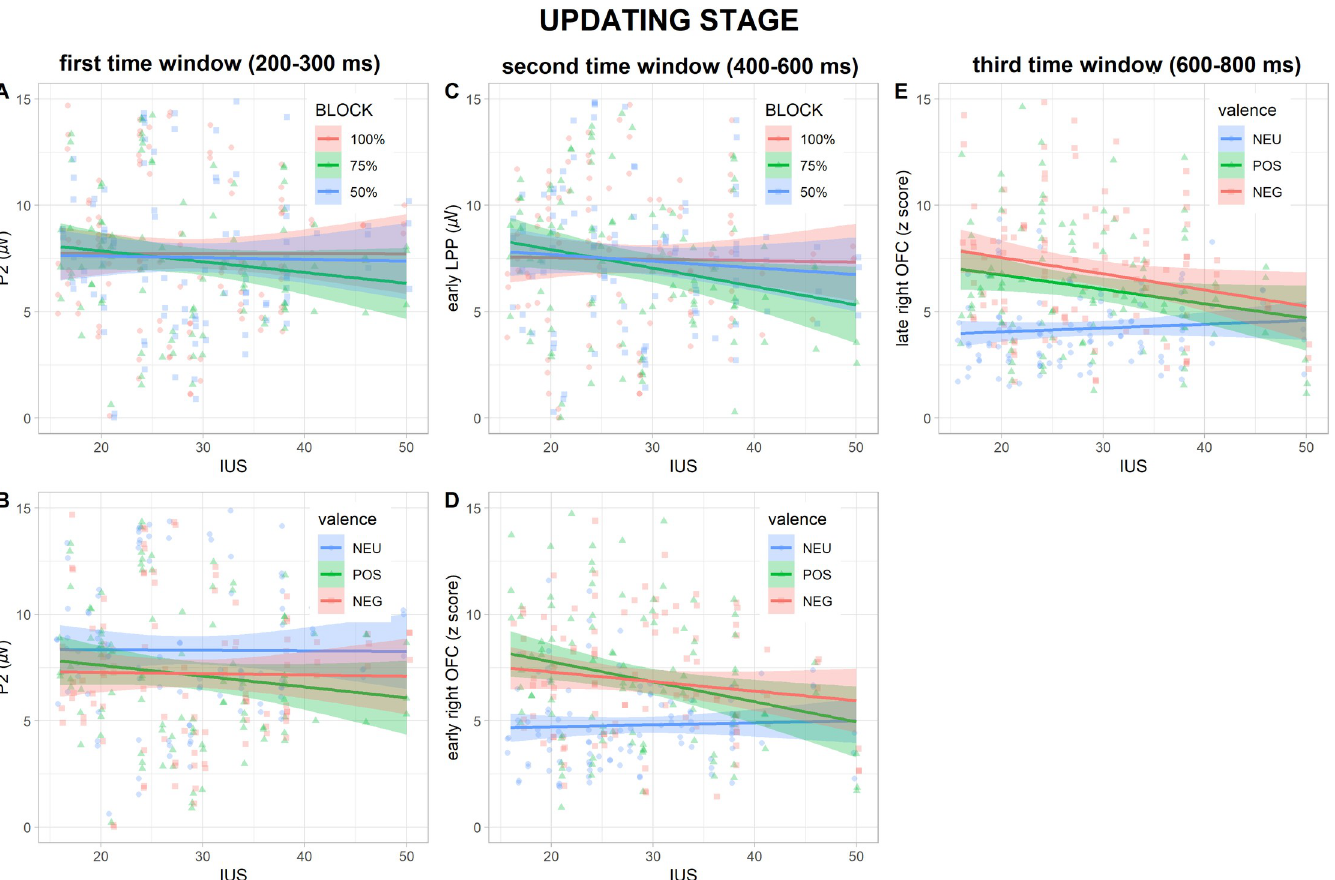
Fig 4. Regression plots in the three time windows of the prediction updating stage. Relationships between IUS scores and (A) P2 amplitude in 100% (in red), 75% (in green), and 50% (in blue) blocks, (B) P2 amplitude to neutral (in blue), positive (in green), and negative (in red) S2s, (C) early LPP amplitude in 100% (in red), 75% (in green), and 50% (in blue) blocks, (D) early and (E) late r-OFC activity to neutral (in blue), positive (in green), and negative (in red) S2s. Shaded areas denote the 95% confidence interval.